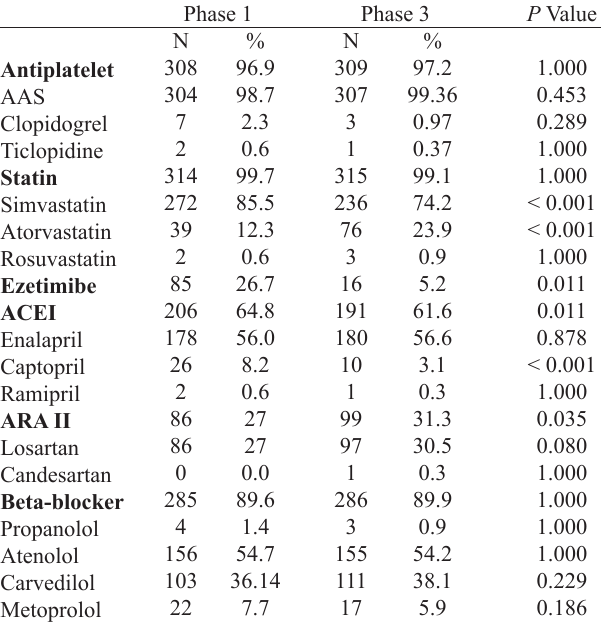
Table 8. Recommended medications